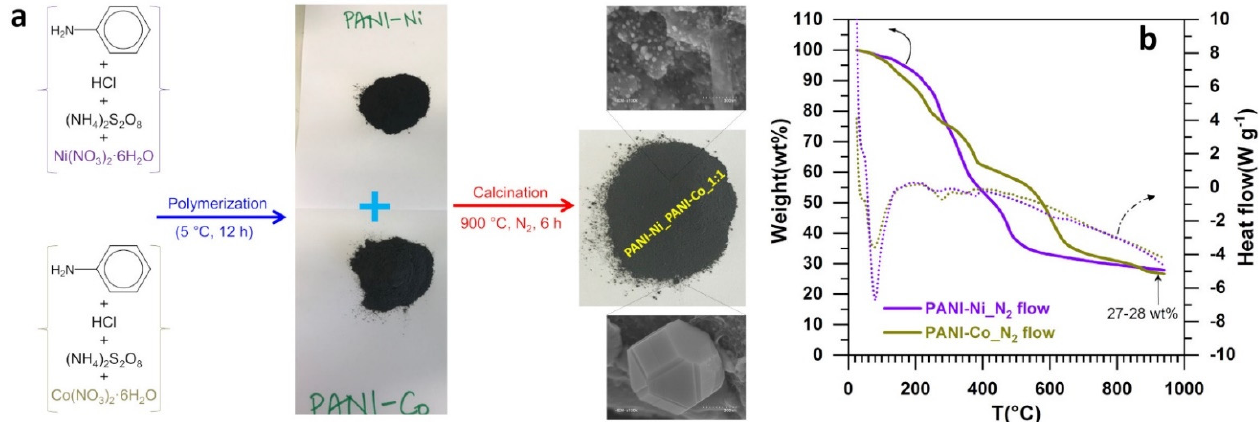
Figure 1. ( a ) Sketch of the engineered approach to produce heterogeneous and self-supported electrocatalysts; ( b ) TGA-DSC profiles the starting materials before any thermal treatment.